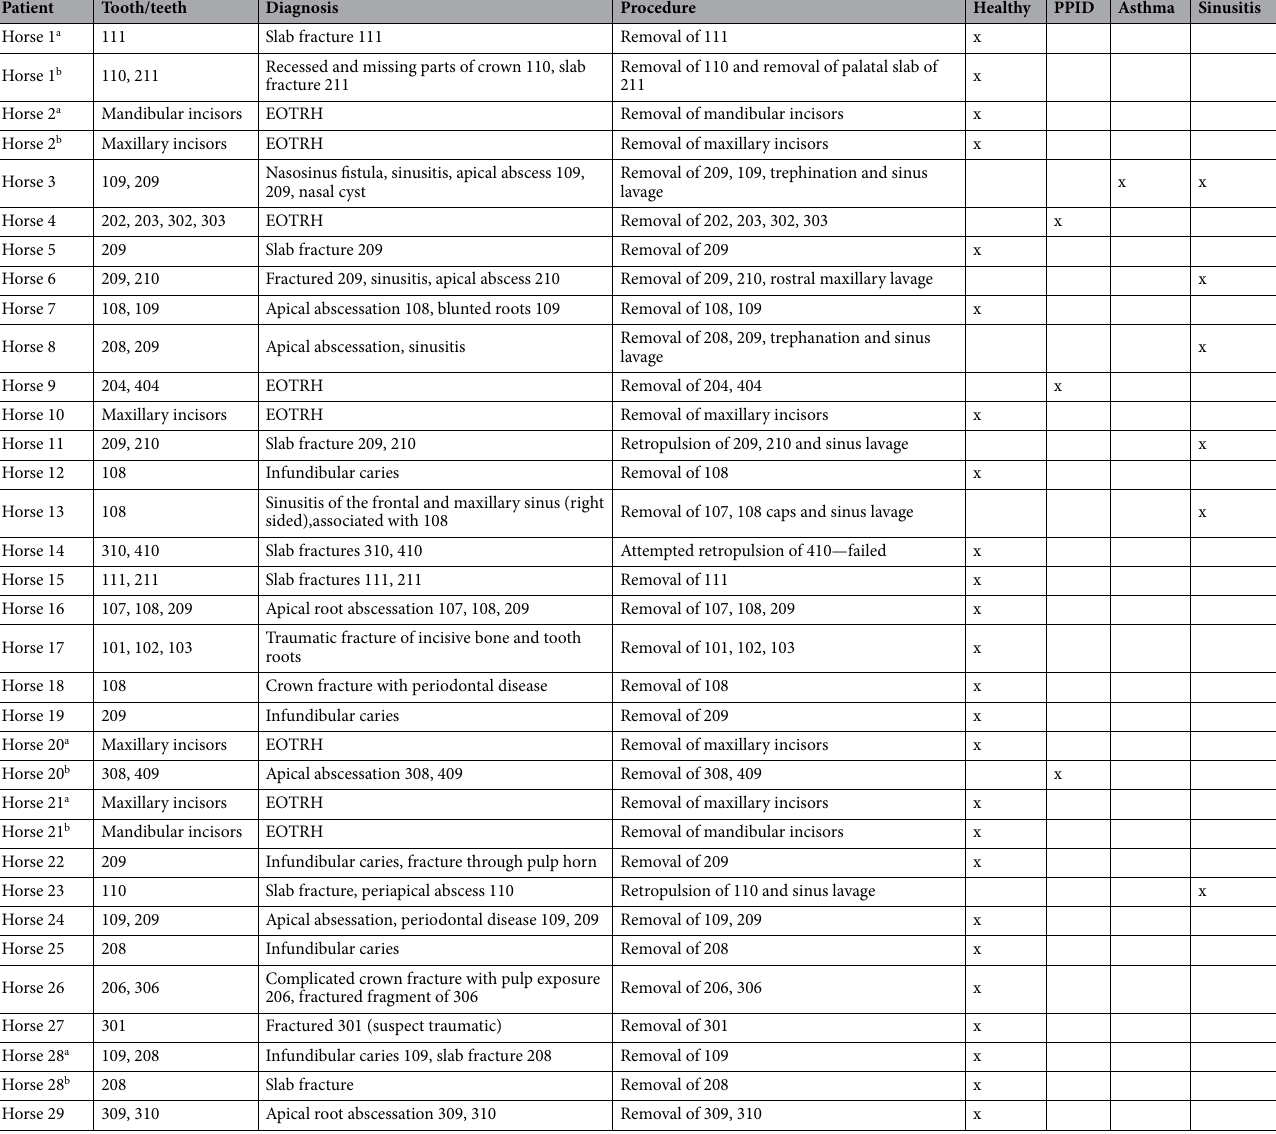
Table 1. Table depicting individual horse information including teeth extracted, diagnosis, surgical procedure, and health designation (healthy, affected with PPID, equine asthma, sinusitis). Teeth were numbered using the Modified Triadan System. a refers to the first visit, b refers to second